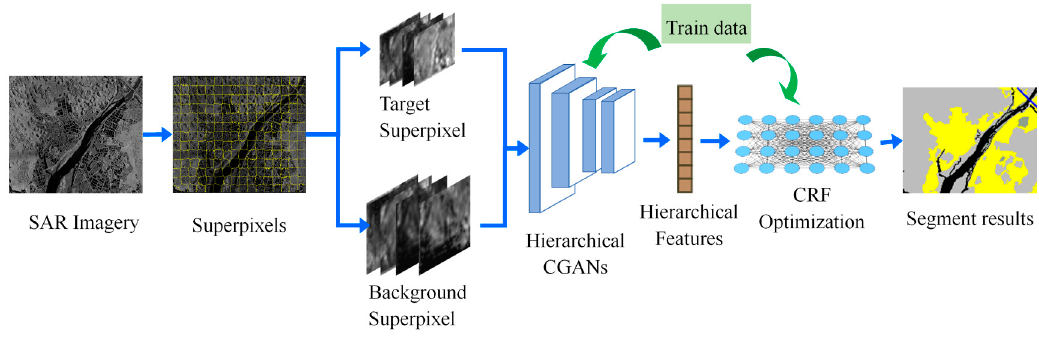
Figure 1. Architecture of our weakly supervised segmentation method based on HACRF.